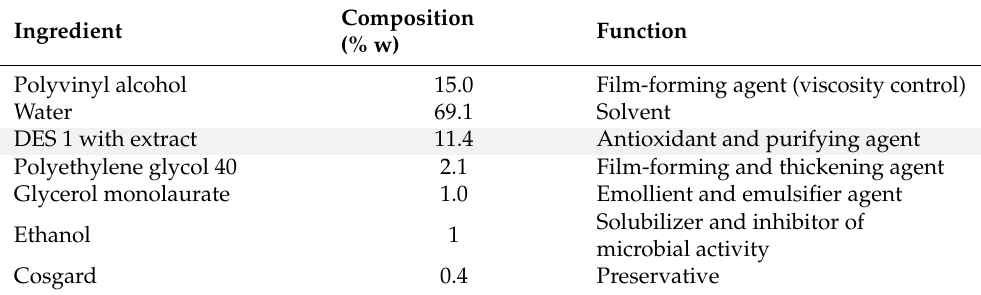
Table 9. Composition of peel-off mask.